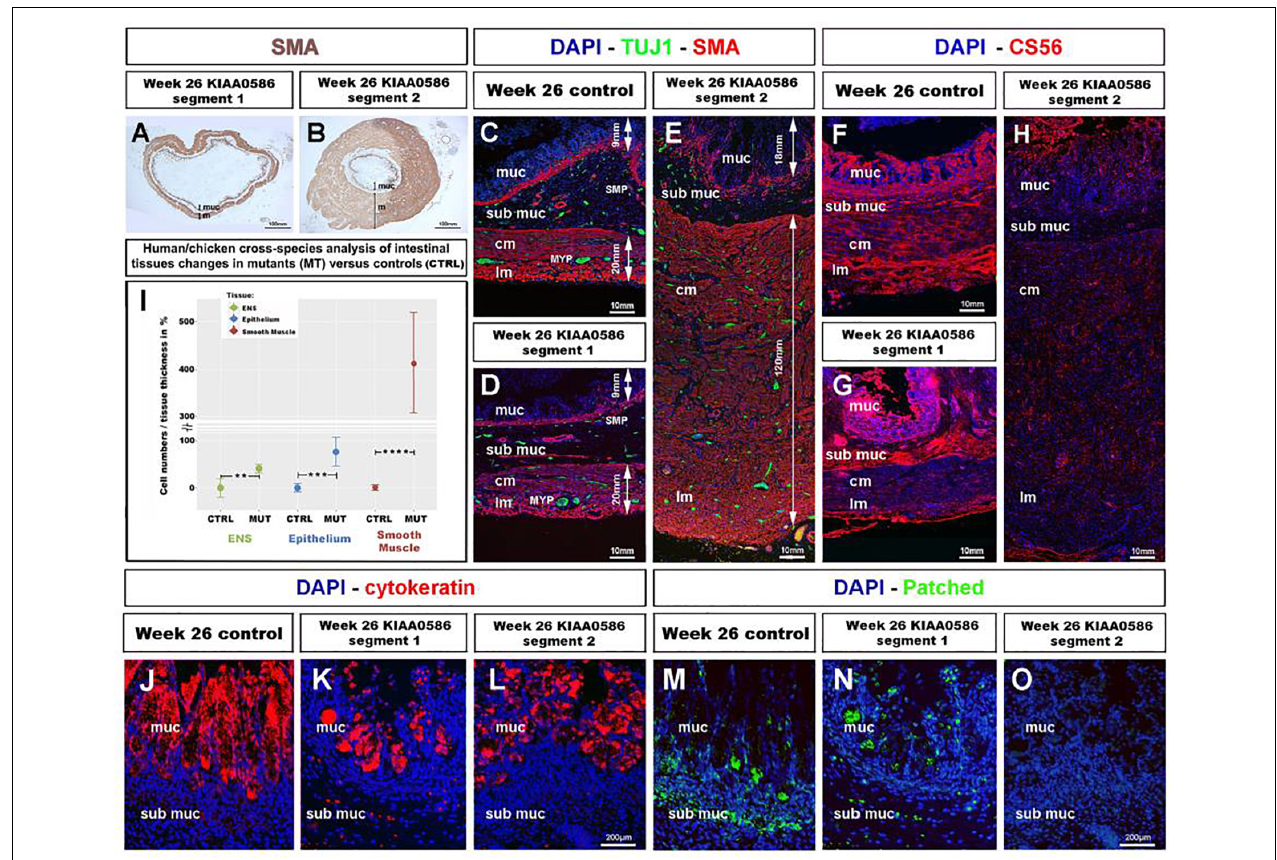
FIGURE 7 | Fetal GI tissues from a 26 weeks human fetus bearing a KIAA0586 mutation show one gut segment with scattered ENS, mucosa and smooth muscle overgrowth, as well as CS56, Cytokeratin and Patched expression defects. (A,B) Low magnification gut sections of a 26 weeks fetus with a KIAA0596 mutation. SMA immuno-staining reveals grossly normal smooth muscle layers in (A) “segment 1” of the intestine and extensive smooth muscle and mucosa overgrowth in (B) “segment 2”. (C–E) Immunofluorescence staining for DAPI (nucleus), TuJ-1 (ENS), and SMA (Smooth Muscle) on intestine sections. (C) 26 weeks control intestine with normal ENS patterning and longitudinal and circular smooth muscle layers. Panels (D,E) staining in the KIAA0586 fetus tissue shows grossly normal neuromuscular pattern in (D) “segment 1,” with well-defined ENS plexuses, normal muscle ( ∼ 20 mm) and mucosa ( ∼ 6 mm) thickness. (E) “segment 2” has scattered ENS with smooth muscle ( ∼ 140 mm) and mucosa ( ∼ 25 mm) overgrowth. (F–H) Immunofluorescence staining for DAPI (nucleus) and CS56 (chondroitin sulfate proteoglycans) on intestine sections. (F,G) 26 weeks control intestine and Segment 1” with CS56 expression in the serosa, submucosa and mucosa. (H) “Segment 2” shows absence of CS56 staining. (I) Human/chicken cross-species analysis of intestinal tissues in talpid 3 and KIAA0586 mutants has statistically significant increase in (i) ENS cells numbers (40.8%,** p = 0.004) and (ii) epithelium and smooth muscle tissue thickness (77%,*** p = 0.00006 and 413%, **** p < 0.0001, respectively). (J,K) Immunofluorescence staining for DAPI (nucleus) and Cytokeratin on mucosal sections. (J) 26 weeks control intestine has uniform Cytokeratin staining in the mucosa. (K,L) “Segment 1 and 2” show uneven Cytokeratin expression. (M–O) Immunofluorescence staining for DAPI (nucleus) and Patched. (M) “Segment 1” has reduced submucosal staining and normal mucosal staining compared to 26 weeks control. (O) “Segment 2” shows no Patched staining. ctrl, control; muc, mucosa; sub muc, submucosa; cm, circular muscle; lm, longitudinal muscle; MYP, myenteric plexus; SMP, submucosal plexus. Same scale bar in (J–O)